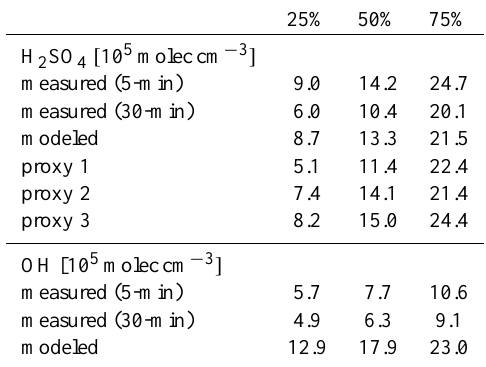
Table 1. Daily maximum sulfuric acid and OH concentrations in Hyyti¨al¨a between 24 March and 27 June 2007. 25%